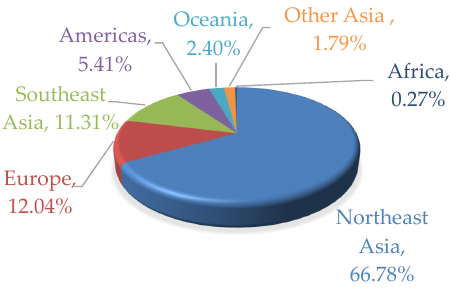
Figure 3. International tourists by region. Source: VNAT (2019).